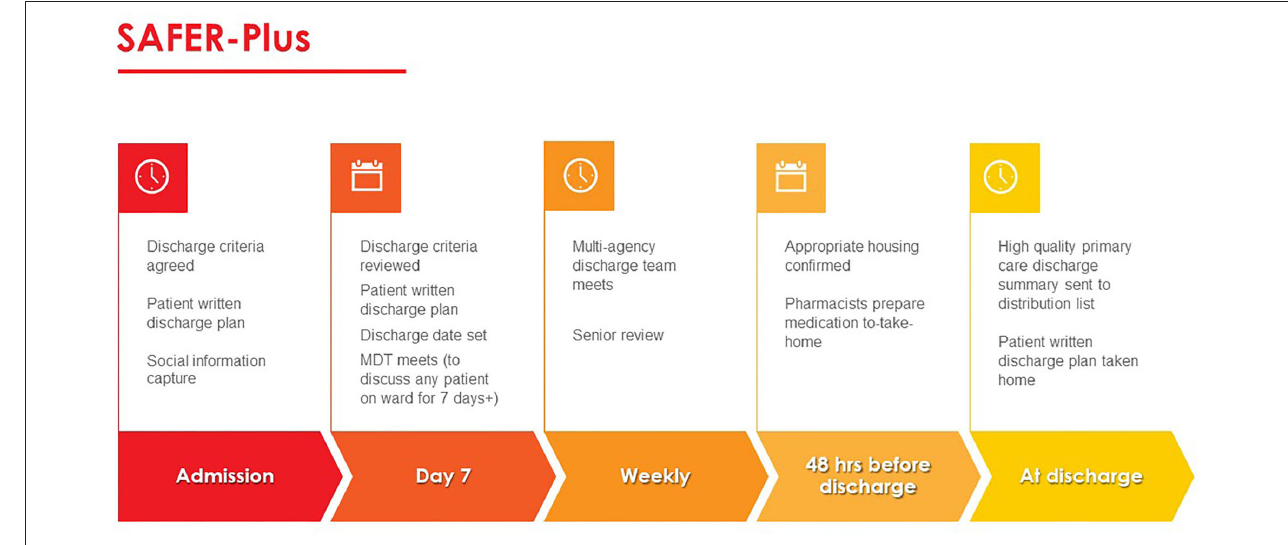
FIGURE 1 | Core components of the intervention (created by